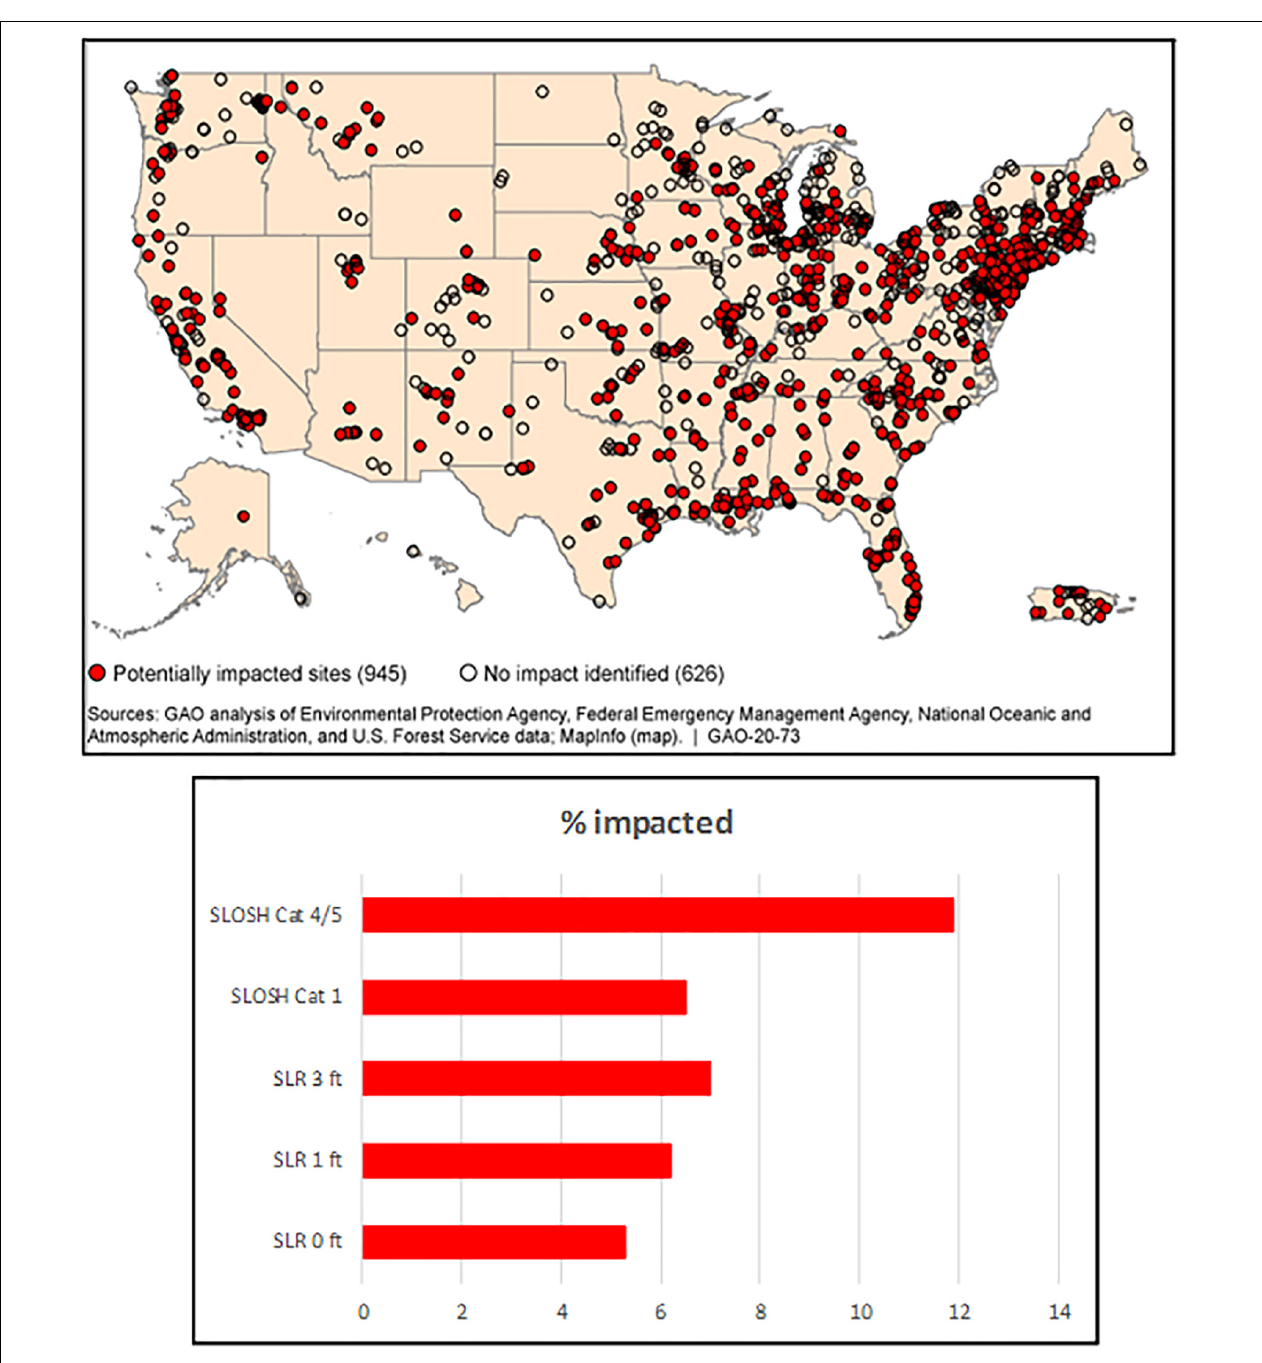
FIGURE 1 | Superfund sites located in areas that may be impacted by flooding, storm surge, wildfires, or sea level rise (top). Bottom graph shows (from top) percentage of sites impacted by Sea, Lake, and Overland Surges by Hurricanes (SLOSH) of category 4 or 5, and category 1, and those expected to be inundated